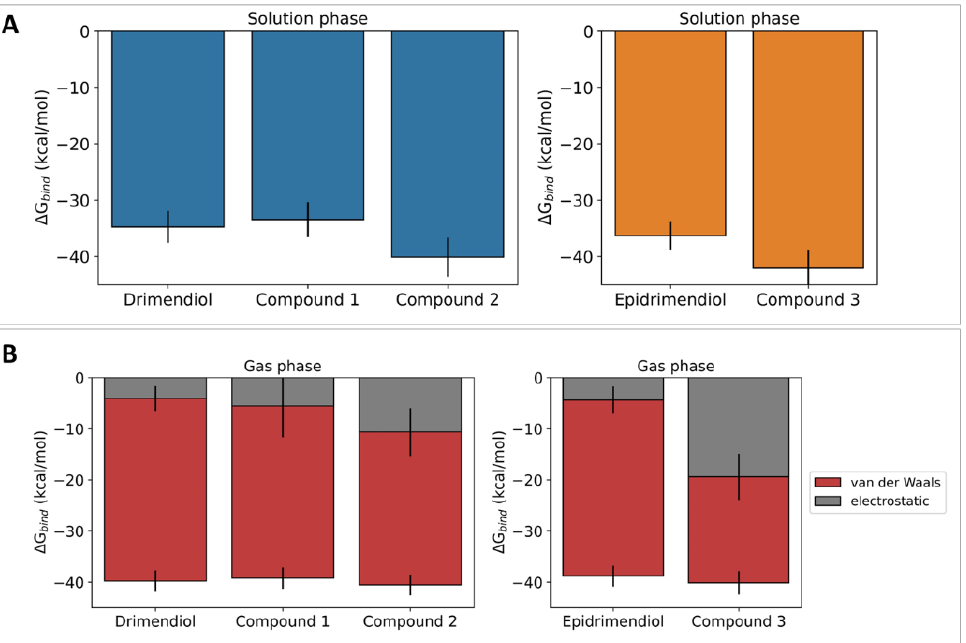
Figure 5. ( A ) Ligand – enzyme binding free energies were estimated from MM/GBSA calculations on 150 MD trajectories for complexes obtained with lanosterol 14α -demethylase. ( B ) Gas-phase binding free energies were obtained for ligand – enzyme complexes as the sum of van der Waals and electro- static contributions. Data were obtained from the analysis 150 ns MD